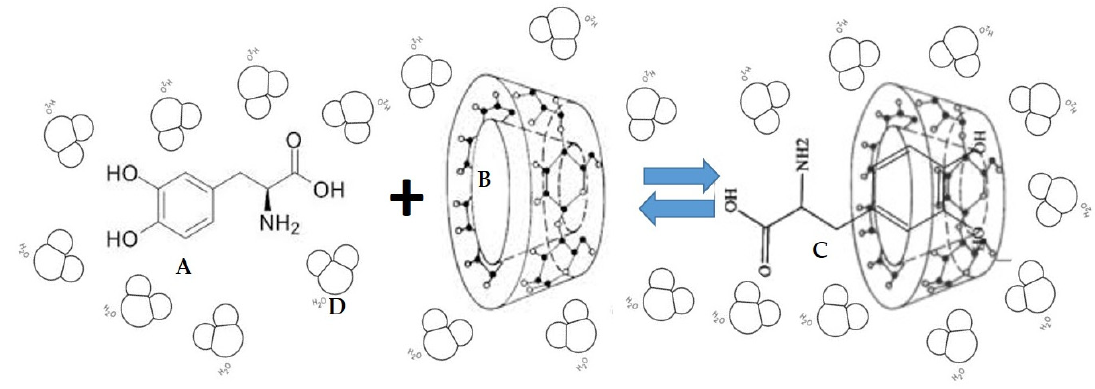
Figure 1. Schematic (speculative) representation of the formation of inclusion complexes L -dopa - β - CD ( C ), between a molecule of L -dopa ( A ) and another of β -CD ( B ) and ( D ) represents the water